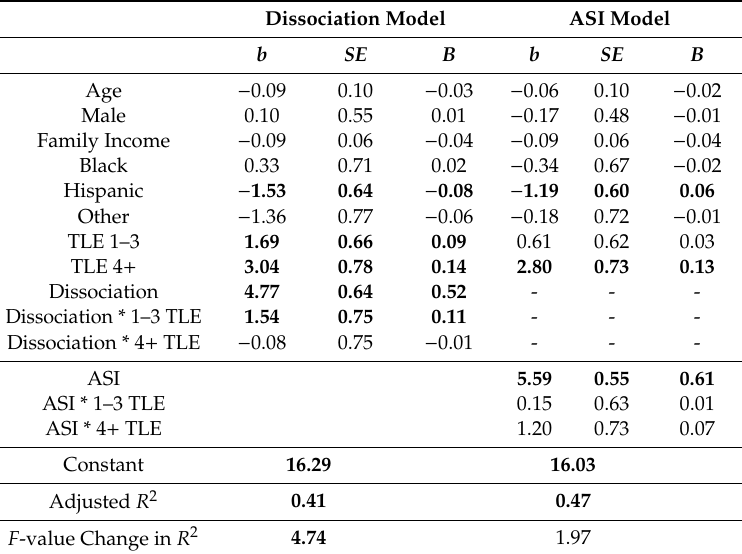
Table 2. Multicategorical hierarchical regression models for the interactions between dissociation and TLE and ASI and TLE predicting